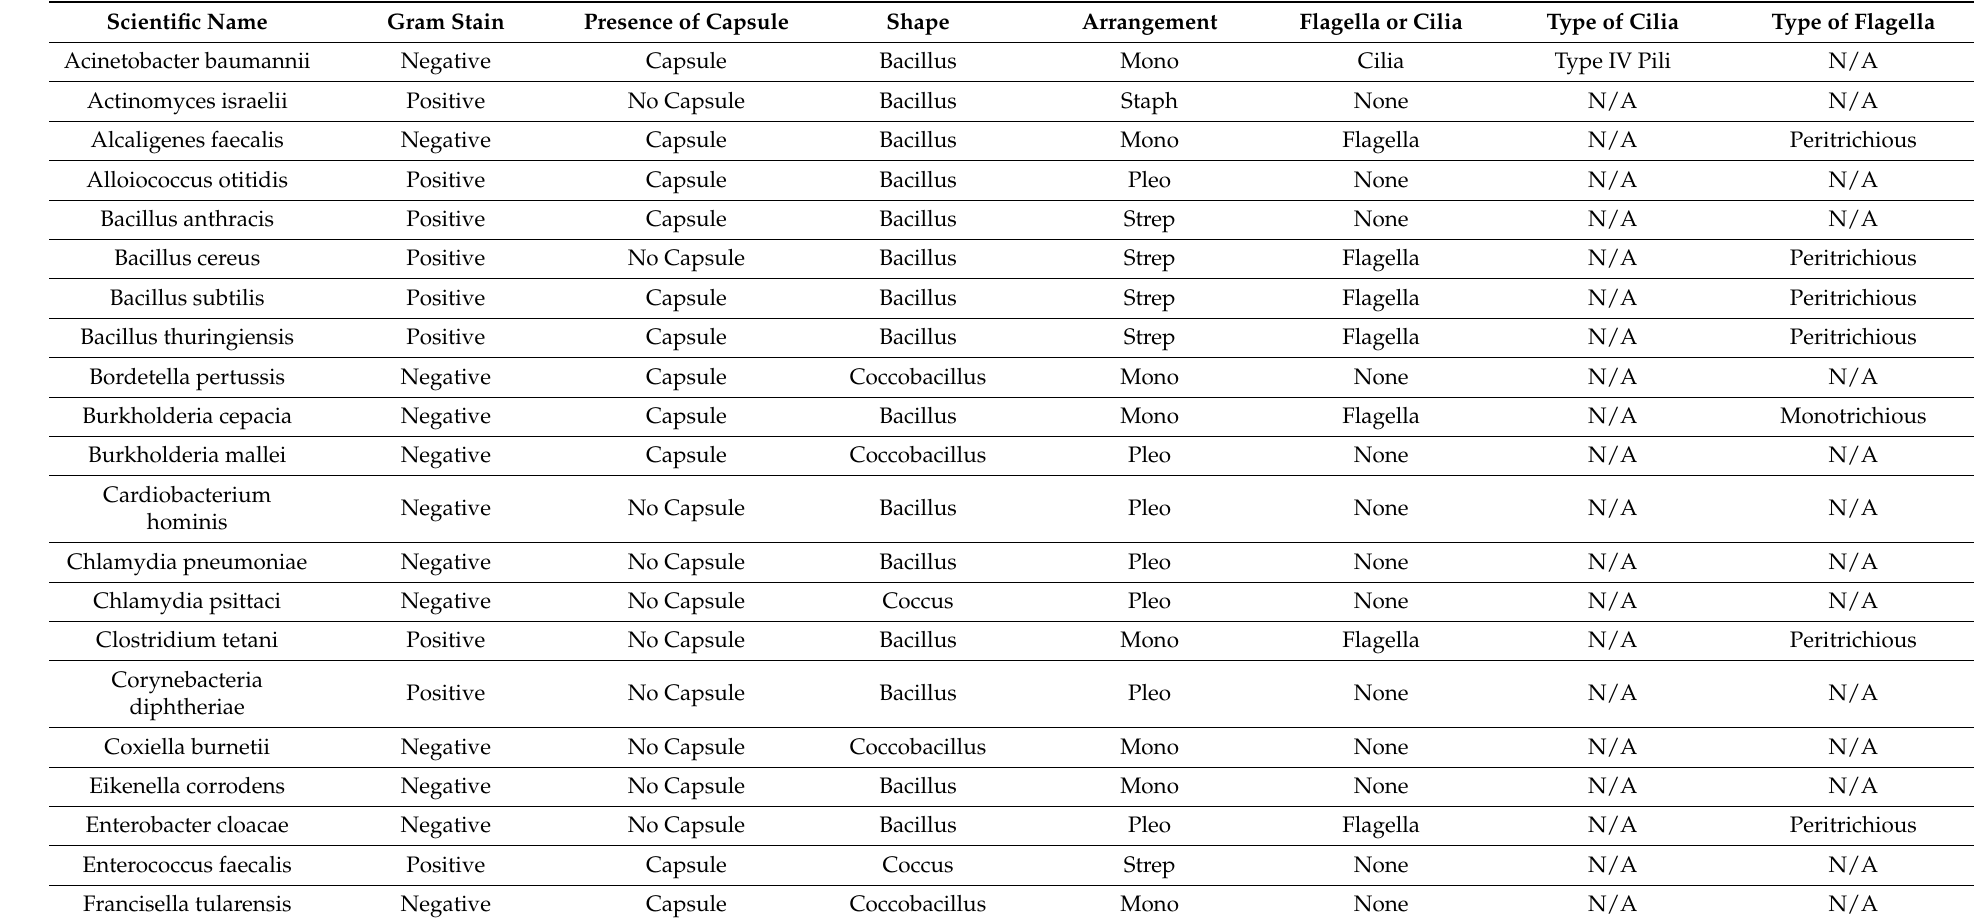
Table 1. Bacterial data set with seven categorical analyzed features, placed in a specific and logical order for decision tree